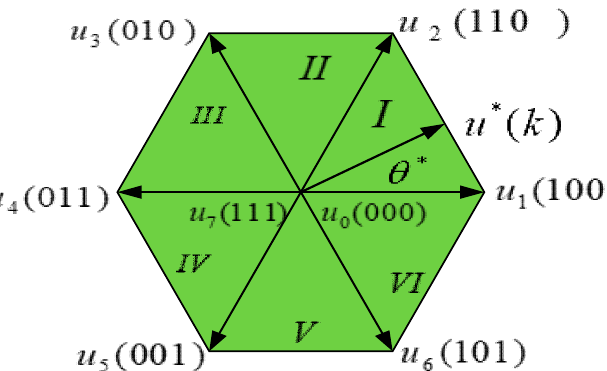
Figure 2. Voltage vectors of the two-level voltage source converter.